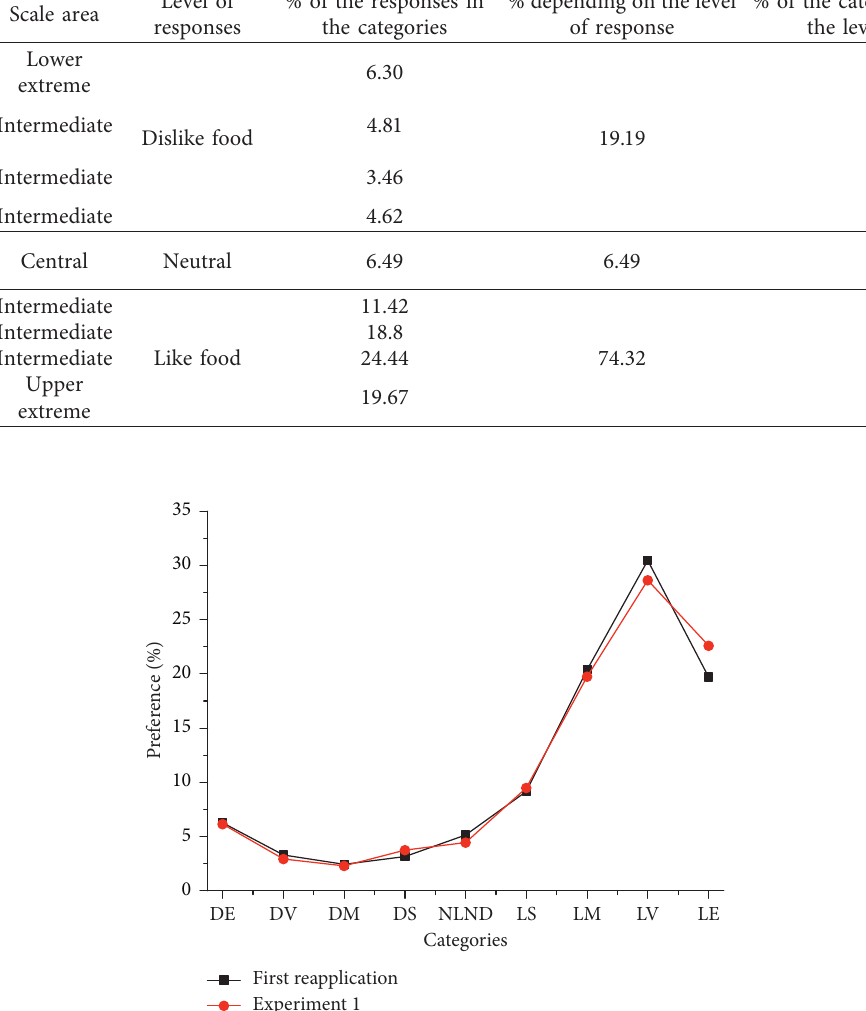
Figure 15: Comparison between the responses of Experiment 1 and the first reapplication.